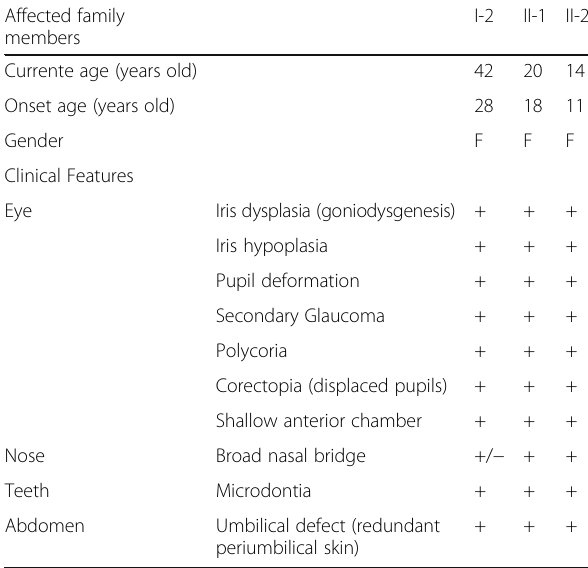
Table 1 Summary of clinical features of affected family members with Axenfeld-Rieger syndrome